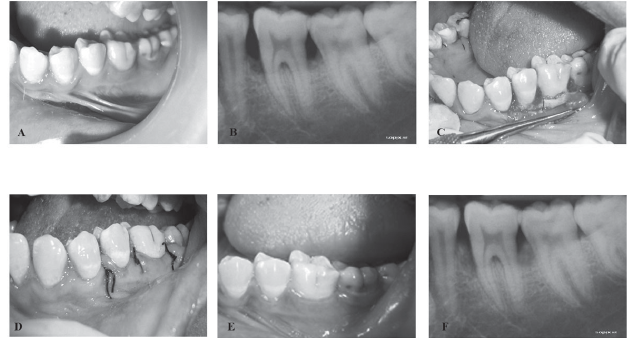
Fig. 2. Surgical procedure in Group I (PRP/BG). A. Preoperative clinical view; B. Preoperative radiograph with intrabony defects on the mesial and distal sides of tooth 36; C. Intraoperative view depicting graft placement after full-thickness flap elevation; D. Postoperative view (after flap closure); E. Postoperative view (6 months); F. Postoperative radiograph (6